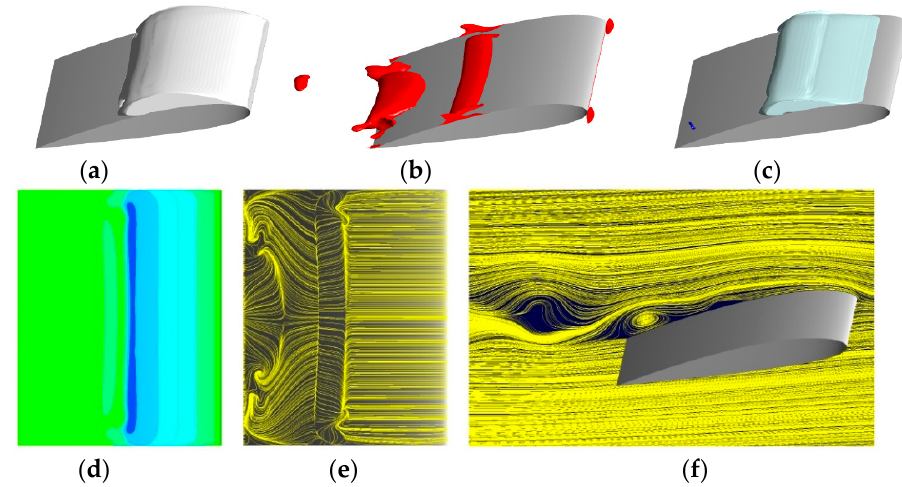
Figure 27. Time instant 7. ( a ) 3D view of cavitation regions (in white); ( b ) back-flow regions (in red); ( c ) evaporation regions (in light cyan) and condensation regions (in dark blue); ( d ) temperature differences on hydrofoil suction side; ( e ) vector lines on hydrofoil suction side; ( f ) vector lines in symmetry plane.